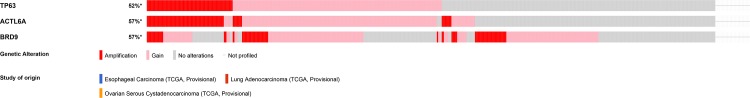
OncoPrint plot.This plot shows the genomic profile of the gain and amplification of TP63, ACTL6A and BRD9 in cancer patients. These TCGA datasets from cBioPortal are based on the following 3 cancer types: ovarian cancer, esophageal cancer and lung adenocarcinoma. Each vertical line indicates one genetic file of the patient. The red bar indicates the amplification, the pink bar indicates the gain, and the gray bar indicates no alteration. ACTL6A is most significantly amplified with TP63 (p<0.001, log odds ratio>3). BRD9 is also significantly amplified with ACTL6A (p<0.001, log odds ratio = 1.051) and TP63 (p<0.001, log odds ratio = 0.907).